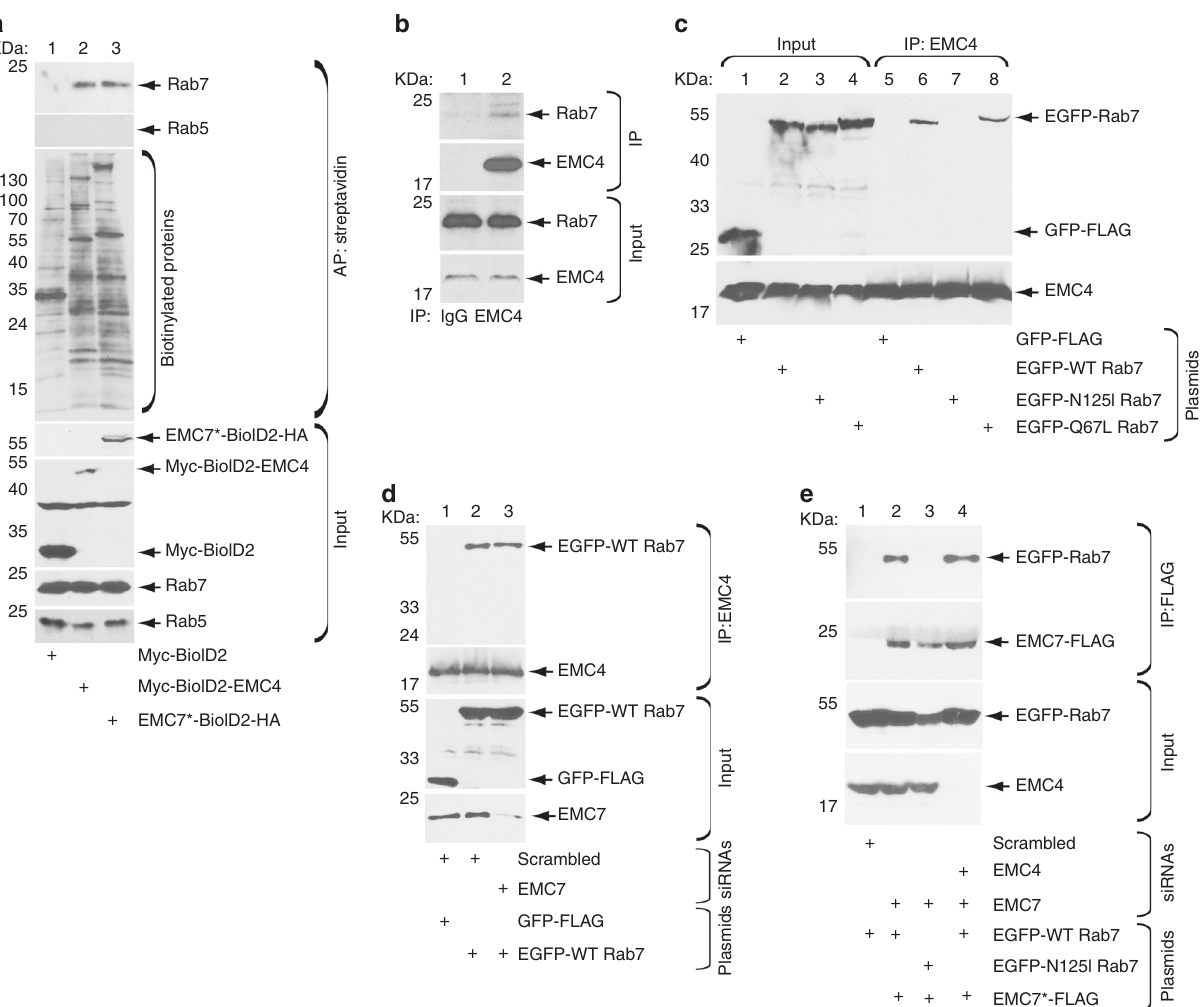
Fig. 4 EMC4 and EMC7 are in close proximity to Rab7 and bind to LE-associated Rab7. a HEK 293 T cells expressing either Myc-BioID2, Myc-BioID2- EMC4, or EMC7-BioID2-HA were treated with biotin, and lysed with a RIPA buffer (containing 1% SDS). The resulting extract was subjected to af fi nity puri fi cation with Streptavidin C1 beads and the bound material eluted by a biotin-containing elution buffer. The input and eluted materials were subjected to SDS-PAGE and immunoblotted with indicated antibodies or probed with Streptavidin-HRP (to detect the total biotinylated proteins in each sample). b HEK 293 T cells were lysed and the resulting extract was incubated with either the control IgG or EMC4 antibody. The precipitated material was subjected to SDS-PAGE followed by immunoblotting with the indicated antibodies. c HEK 293 T cells transfected with the indicated plasmid were lysed, the resulting extract was incubated with EMC4 antibody, and the precipitated material subjected to SDS-PAGE and immunoblotting with the indicated antibodies. d – e HEK 293 T cells transfected with the indicated siRNA and DNA construct were lysed and the resulting extract was incubated with either an EMC4 ( d ) or FLAG antibody-conjugated agarose beads ( e ). The precipitated material was subjected to SDS-PAGE and immunoblotted with the indicated antibodies. All experiments were independently repeated three times. Source data are provided as a Source Data fi that Rab7 ’ s interaction with EMC4 and EMC7 is distinct from the